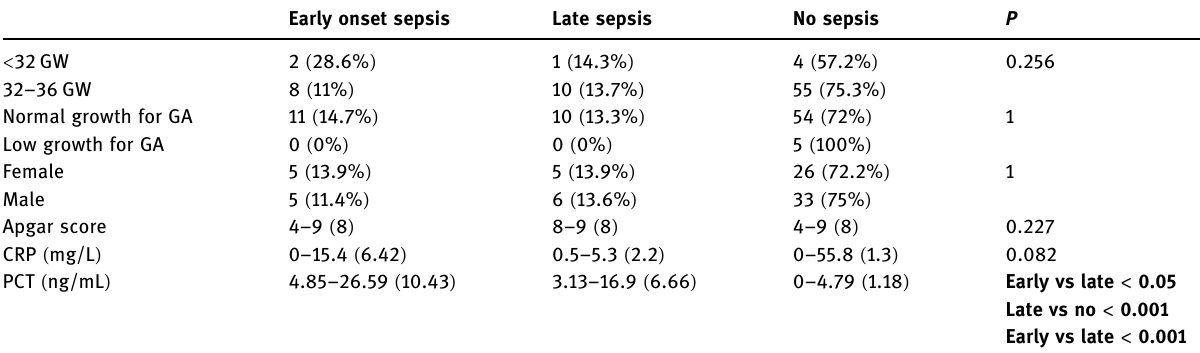
Table 2: Comparison of some clinical variables and levels of CRP and PCT among subjects by sepsis